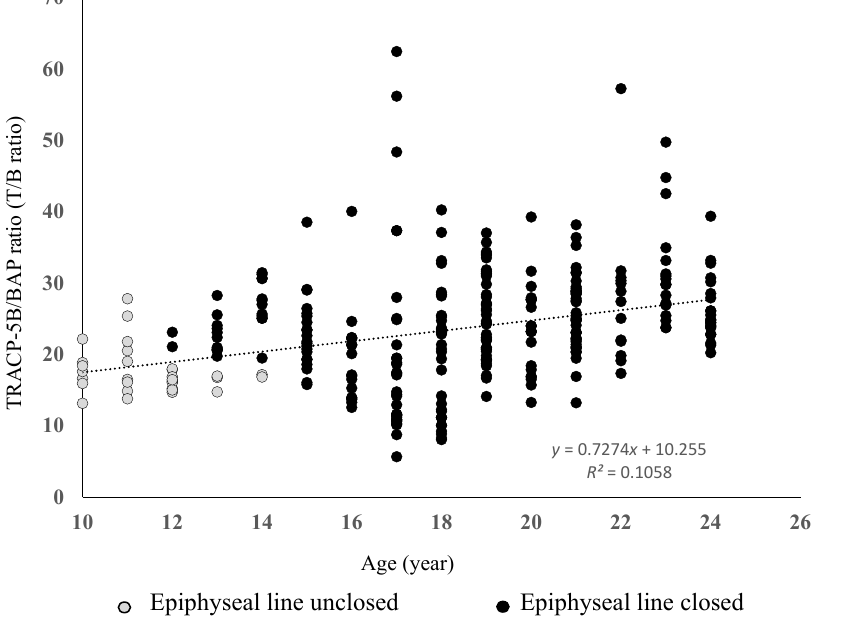
Figure 2. Ratio of bone metabolism markers according to age. The ratio of bone metabolism markers indicates the bone turnover rate. The ratio of these markers showed smaller individual differences compared with the individual bone metabolism markers, and decreased linearly with